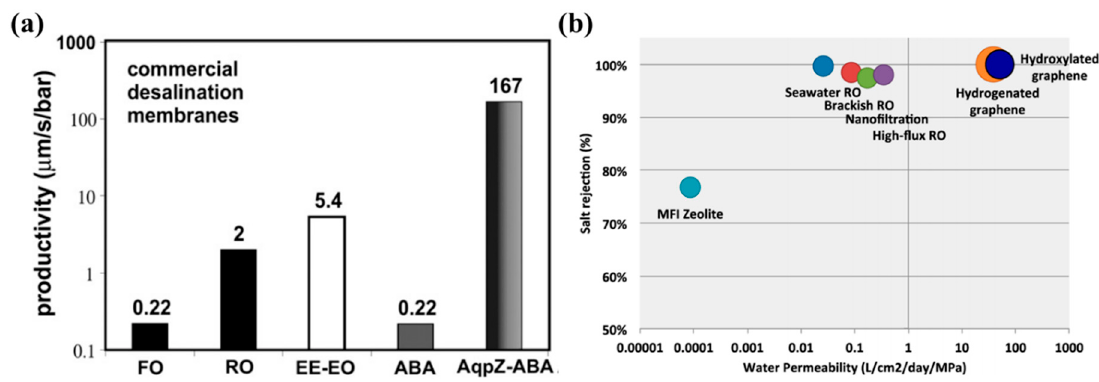
Figure 14. A comparison of the water permeability of ( a ) an aquaporin membrane [115] and ( b ) a graphene membrane [114] to those of other commercial membranes. ‘Productivity’ on ( a ) is a unit which represents the same unit of ‘permeability’. In ( a ), EE-EO stands for a poly(ethylethylene)-poly(ethylene) oxide diblock polymer; ABA stands for a polymer vesicle without AqpZ; and AqpZ-ABA stands for a polymer vesicle with AqpZ. The figures are reproduced from References [115,114], respectively, with permission.